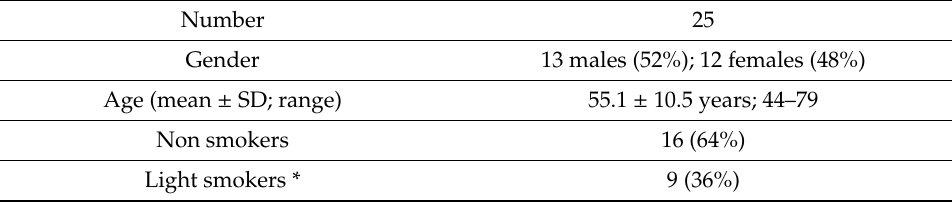
Table 1. Patient demographics and characteristics at